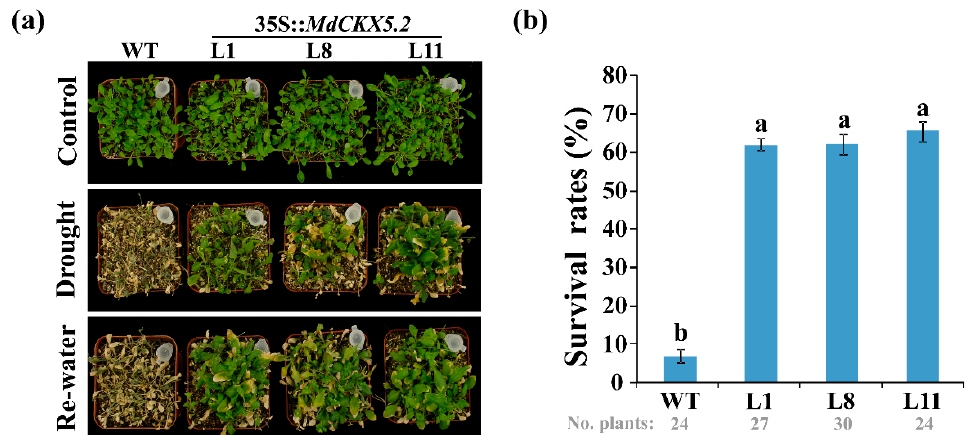
Figure 6. Drought tolerance of MdCKX5.2 transgenic Arabidopsis . ( a ) Phenotypes of 2-week-old transgenic (L1, L8 and L11) and wild-type (WT) plants before and after drought treatment for 20 days (Drought) and re-watered for 2 days (Re-water). ( b ) Survival rates of transgenic and WT lines after re-watered. The gray numbers under the charts indicate the number of plants measured (No. plants). Error bars, ±SD. The letters (a and b) indicate statistically significant differences ( p < 0.05) between different groups by analysis of variance (ANOVA).